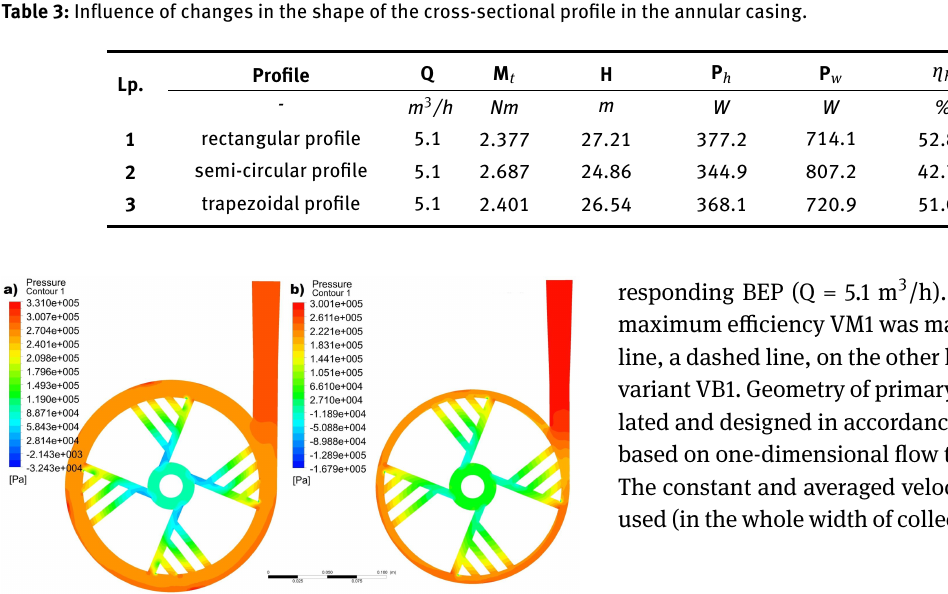
Table 3: Influence of changes in the shape of the cross-sectional profile in the annular casing.